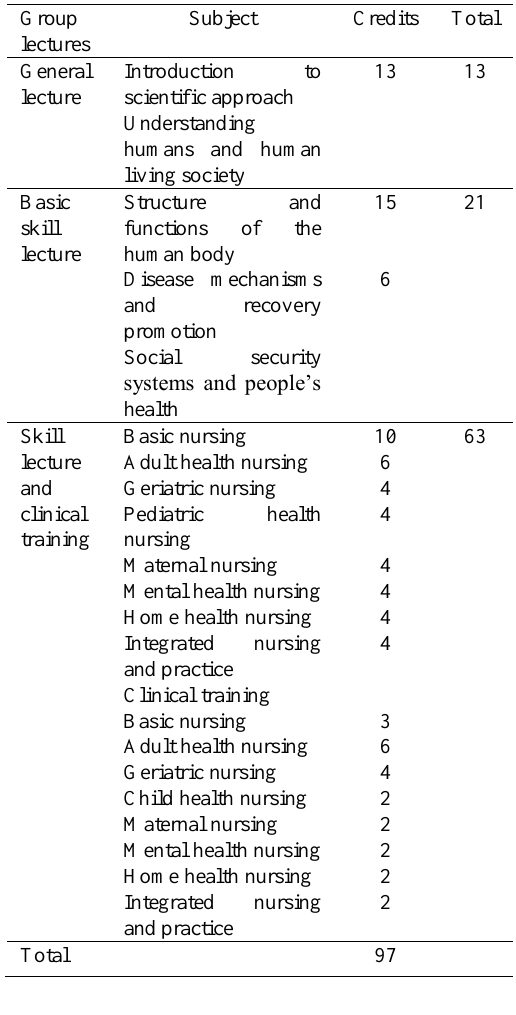
Table 2. Japanese national curriculum for